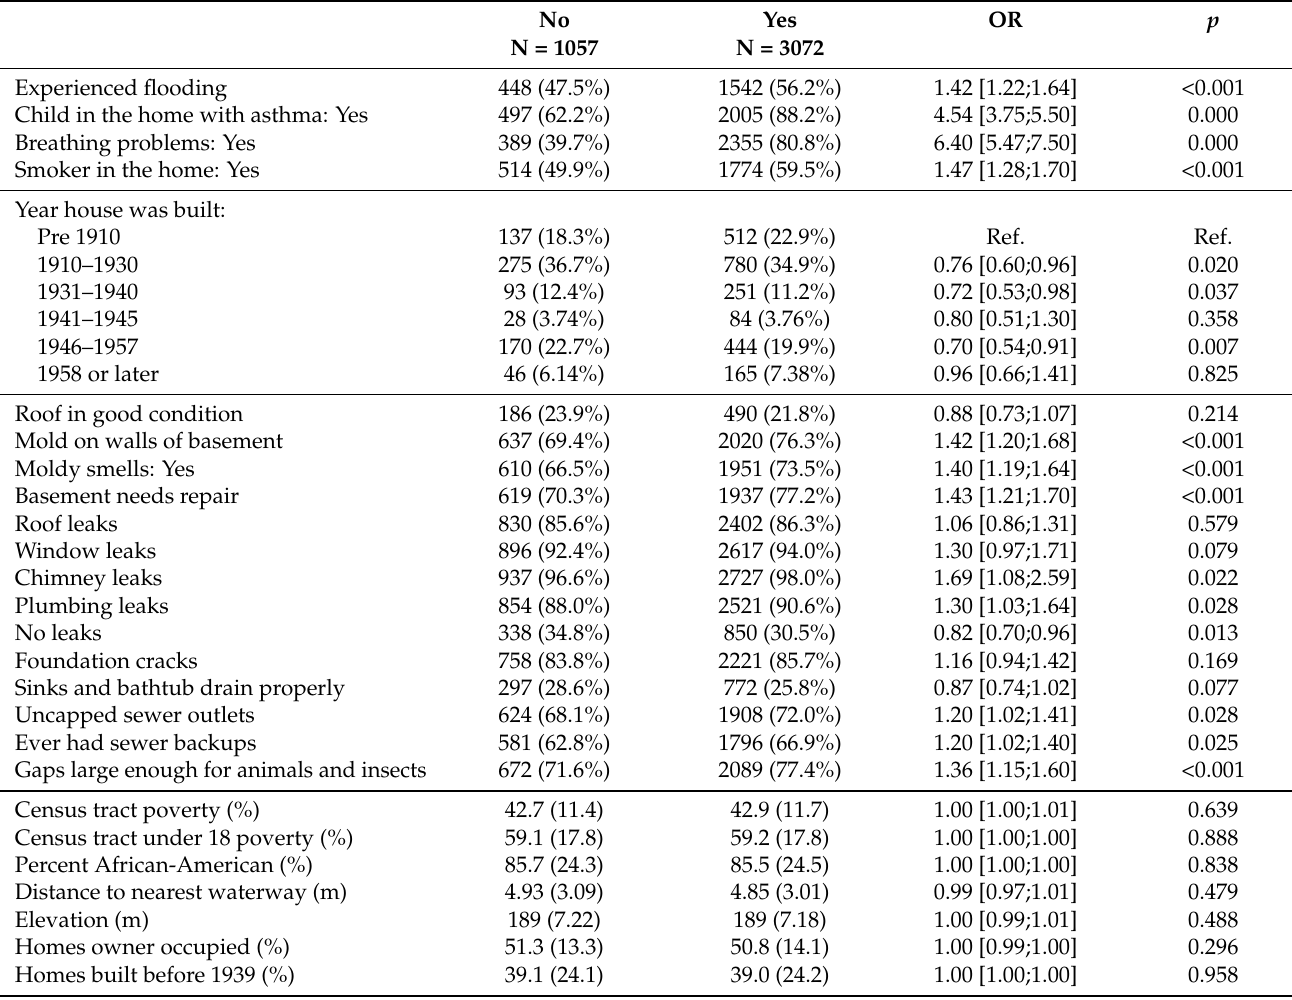
Table 5. Prevalence and determinants of asthma in at least one adult member of the household. Odds ratios for continuous measures from standardized values